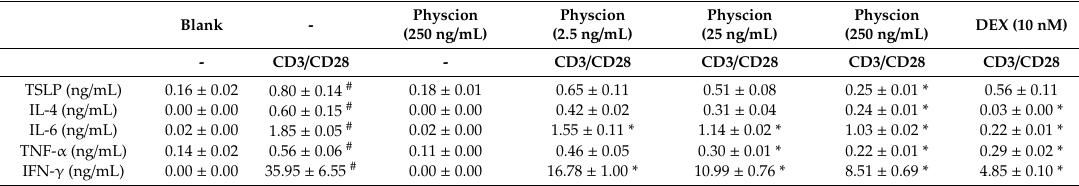
Figure 4. Physcion attenuates mitogen-activated protein kinase (MAPK)s and pIKK β / NF- κ B / pIkB α expressions in PMACI-stimulated HMC-1 cells. ( A ) HMC-1 cells (5 × 10 6 ) were treated with Physcion or DEX for 1 h and then stimulated with PMACI for 30 min. Representative immunoblots are shown. ( B ) Each relative intensity of protein levels was quantified by densitometry and shown as pERK / ERK, pJNK / JNK, and pp38 / p38. ( C ) HMC-1 cells (5 × 10 6 ) were treated with Physcion or DEX for 1 h and then stimulated with PMACI for 1 h (pIKK β ) or 2 h (NF- κ B and pI κ B α ). Representative immunoblots are shown. ( C, top ) Whole extract probed with anti-pIKK β antibody. ( C, middle ) Nuclear extract probed with anti-NF κ B p65 antibody. ( C, bottom ) Cytosolic extract probed with anti-pI κ B α antibody. ( D ) Each relative intensity of protein levels was quantified by densitometry and shown as pIKK β / GAPGH, NF- κ B / PARP, and pI κ B α / GAPGH. # p < 0.05 vs. a non-stimulated group. * p < 0.05 vs. a PMACI-stimulated group. Table 1. Physcion attenuates thymic stromal lymphopoietin (TSLP) production in anti-CD3 and anti-CD28 antibodies-stimulated